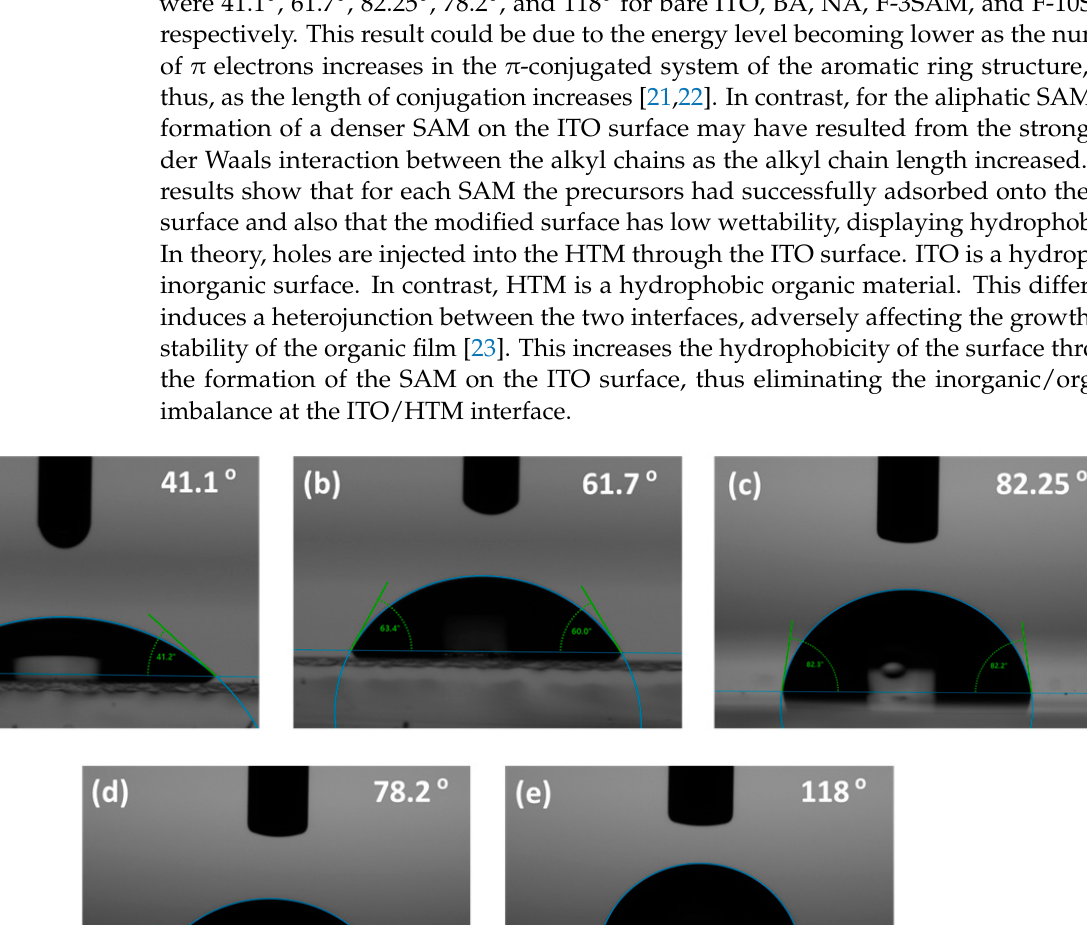
Figure 4. Contact angle measurement result and coverage quantitative ratio. These results indicate that the ITO interface had a higher contact angle when the ali- phatic alkyl chain length was increased than when the number of aromatic rings was in- creased. This can be expressed as a quantitative ratio through Cassie's law, which is shown below. cos𝜃 = (cid:4666)1 − 𝐶 (cid:2869) (cid:4667) cos 𝜃 (cid:2869) + 𝐶 (cid:2869) cos 𝜃 (cid:2870) When C 1 has a value between 0 and 1, θ 1 is the contact angle of bare ITO, and θ 2 is the contact angle of the ITO surface modified by F-10SAM in the above equation, the quanti- tative ratio of SAMs based on Cassie’s law is shown in Figure 4. The ratios are 0% for bare ITO, 34.3% for BA, 73.7% for NA, 44.8% for F-3SAM, and 100% for F-10SAM. This equation confirms that for different SAM-modified ITO surfaces, higher hydrophobicity was exhib- ited when the aliphatic chain length was increased than when the number of aromatic rings was increased. Figure 5 and Table 1 show the atomic force microscope images and the average roughness values from measurement results on bare ITO, the aromatic-NA-modified ITO